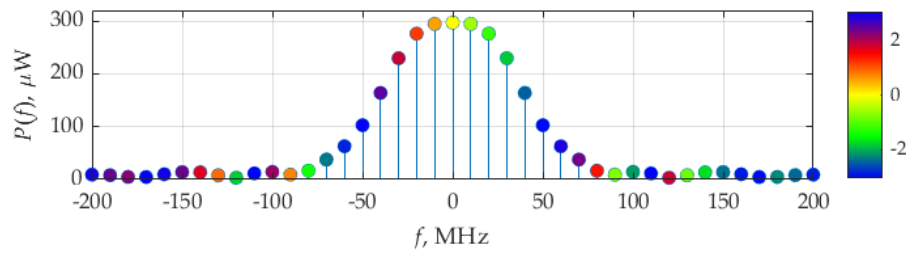
Figure 19. The spectrum of p ( t ) for the case of transmission line and pulse train current.